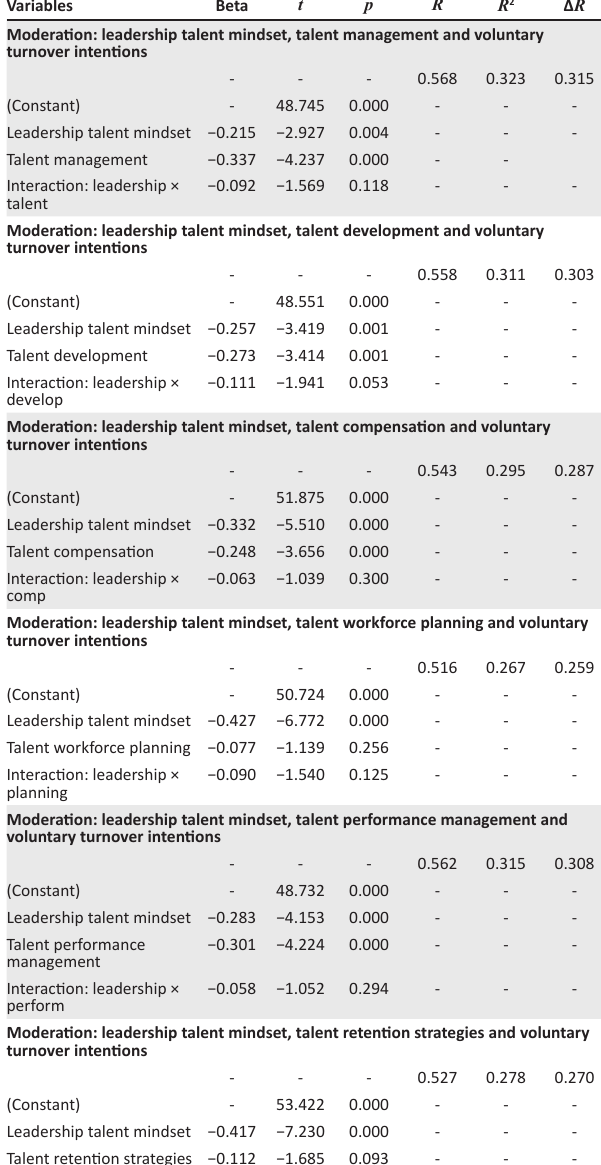
TABLE 3: Results of moderation analyses. TABLE 2: Results of linear regression analyses.